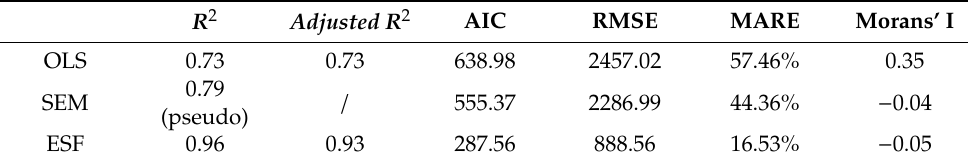
Table A3. Model performance without NTL variable in 2017.